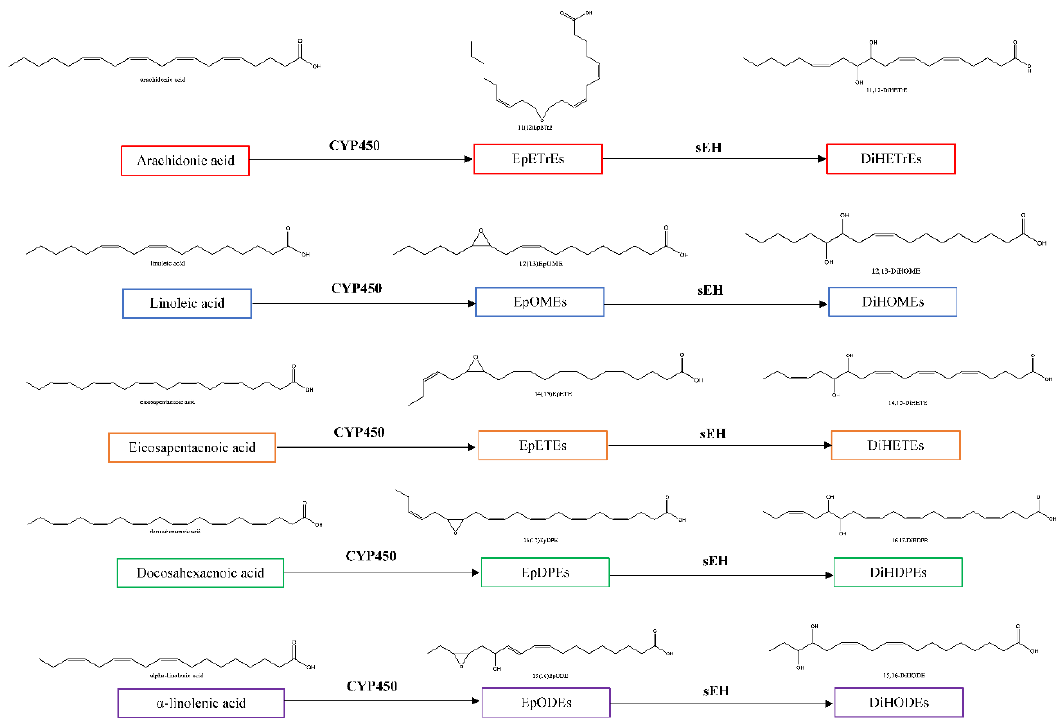
Figure 1. Overview of the cytochrome P450-soluble epoxide hydrolase (CYP450-sEH) oxylipin pathway. Dietary fatty acids as such as arachidonic acid, linoleic acid, eicosopentanoic acid, do-